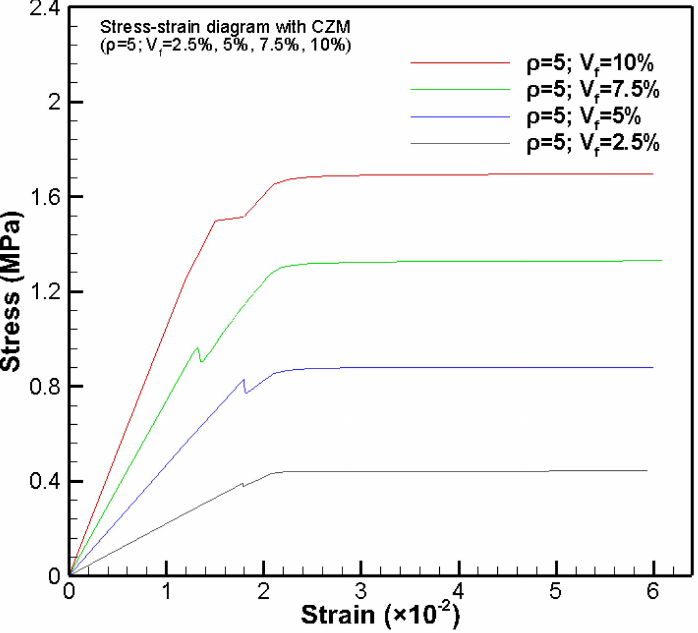
Figure 21. Effective stress-strain diagrams of the PNC (reinforced with edge-curved clay nanoparti- cles) with CZM at the nanoparticle volume fraction of V f = 2.5%, 5%, 7.5%, and 10%, respectively ( ρ =